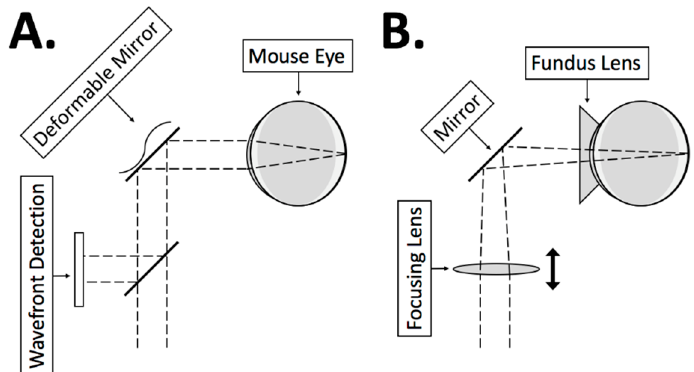
Figure 2. ( A ) Non-contact OCT systems for murine retinal imaging rely on the natural optics of the mouse eye to focus the beam. Without expensive adaptive optics, the beam is subject to severe aberrations of the mouse eye. ( B ) A contact lens uses a fundus lens with one flat surface and another concave surface that is indexed matched to the cornea. This approach limits the aberration contribution of the air–cornea interface. Instead of entering the eye collimated, the beam enters with some optical power from a focusing lens. The focusing lens adjusts the focal plane at the retina to account for variations in eye length between mice.